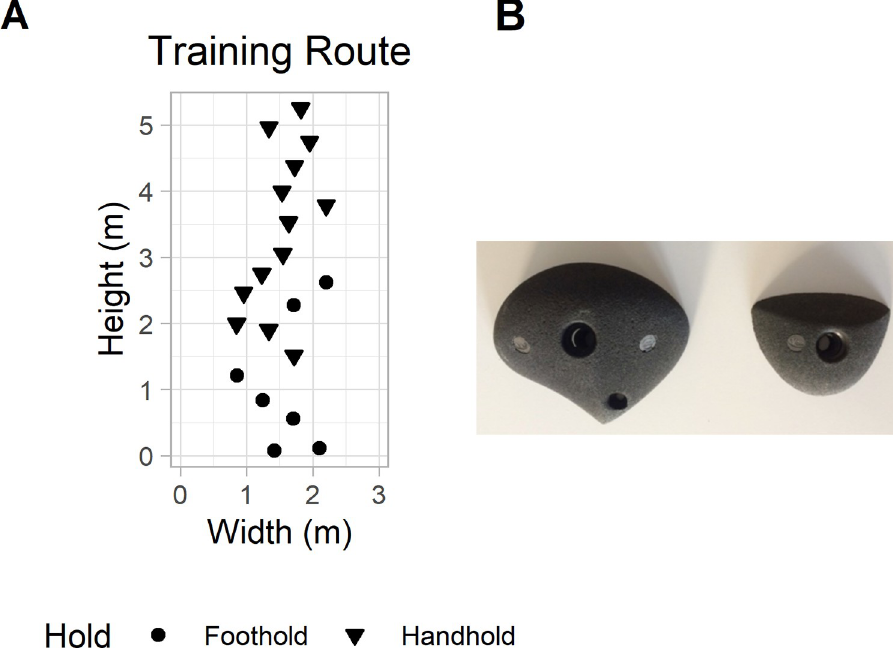
Fig 1. Presentation of the training route and the climbing holds. (A) Design of the training route. (B) Model of handhold (on the left) and model of foothold (on the right) used to create the routes.